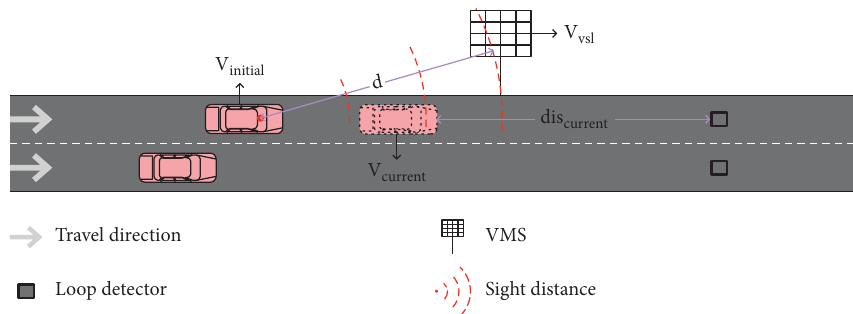
Figure 1: Illustration of the basic VSL control